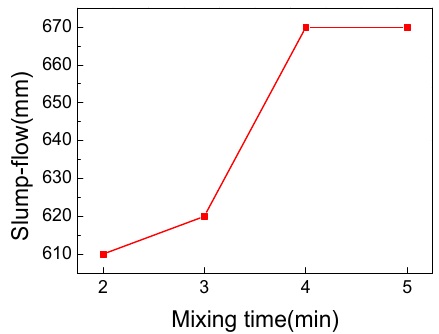
Figure 5. E ff ect of mixing time on the slump-flow of Figure 5. Effect of mixing time on the slump-flow of SCC.